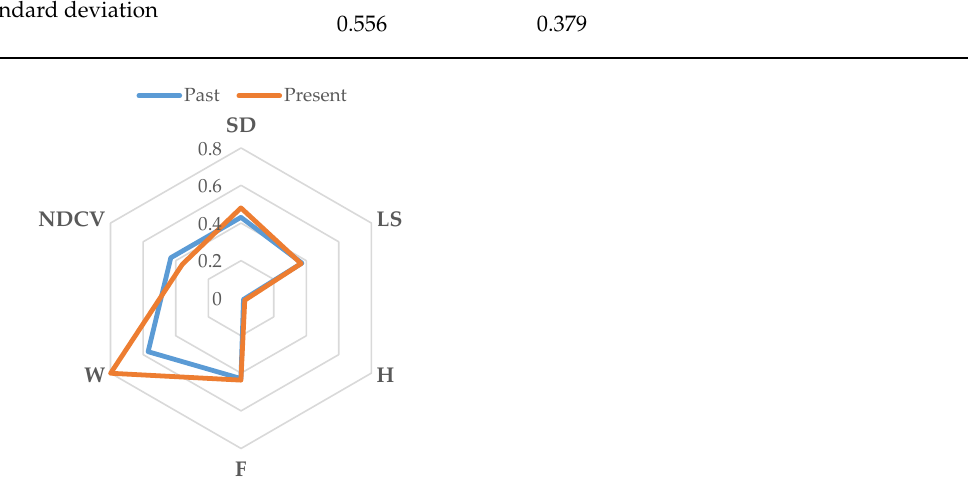
Figure 5. Vulnerability spider diagram of the major components of the LVI for the present and past decades in Polder 31.